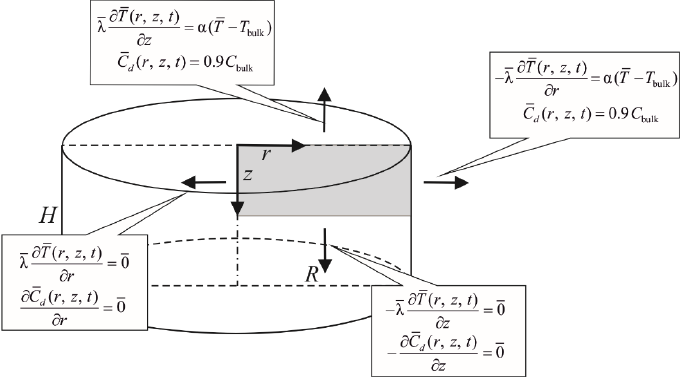
Figure 1. Domain considered and boundary conditions.